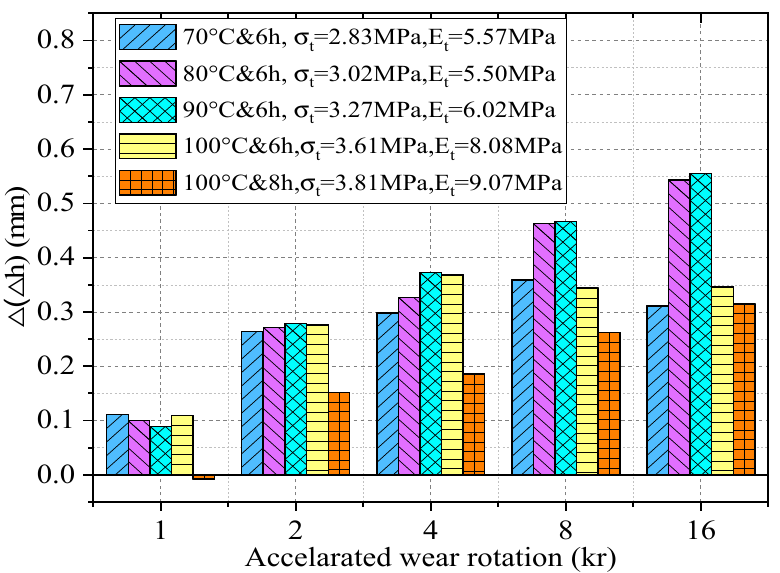
Figure 8. The difference Δ ( Δ h) of polyurethane mixture under different conditions.